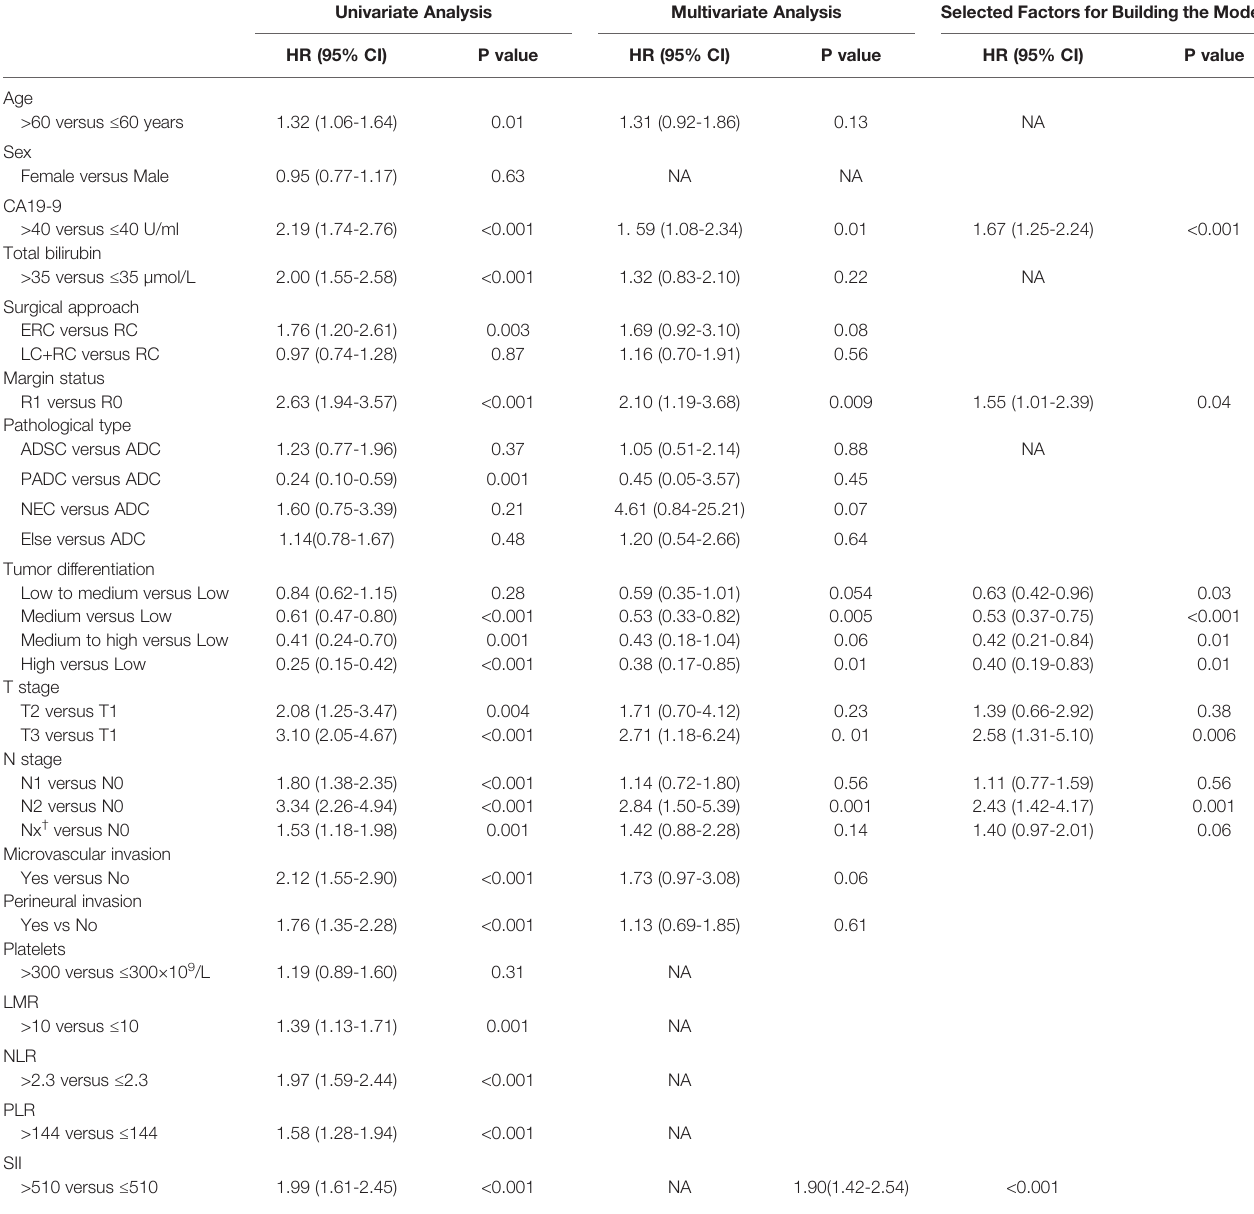
TABLE 2 | Cox Proportional Hazards Regression Models for Predictor Selection and Model